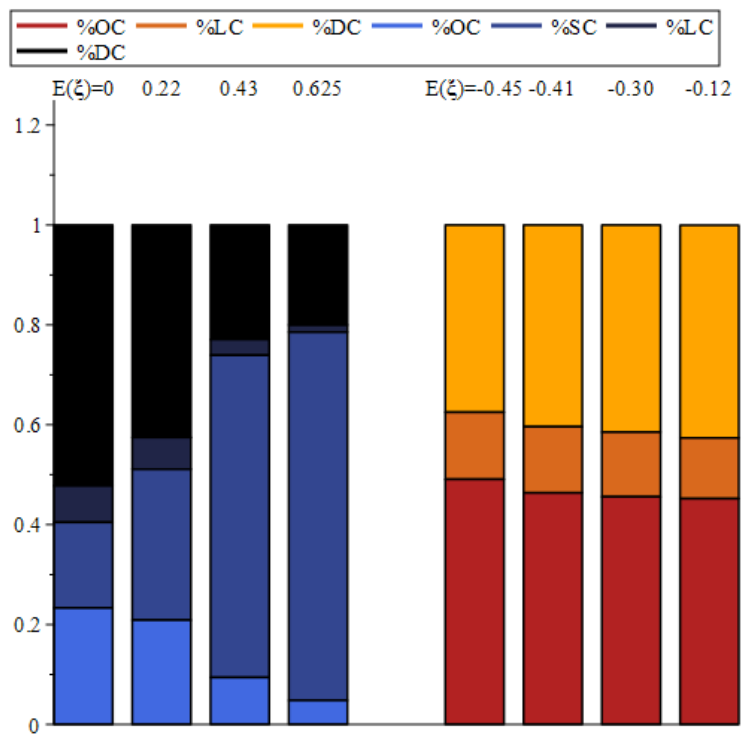
Figure 6. The %cost components, Scenario